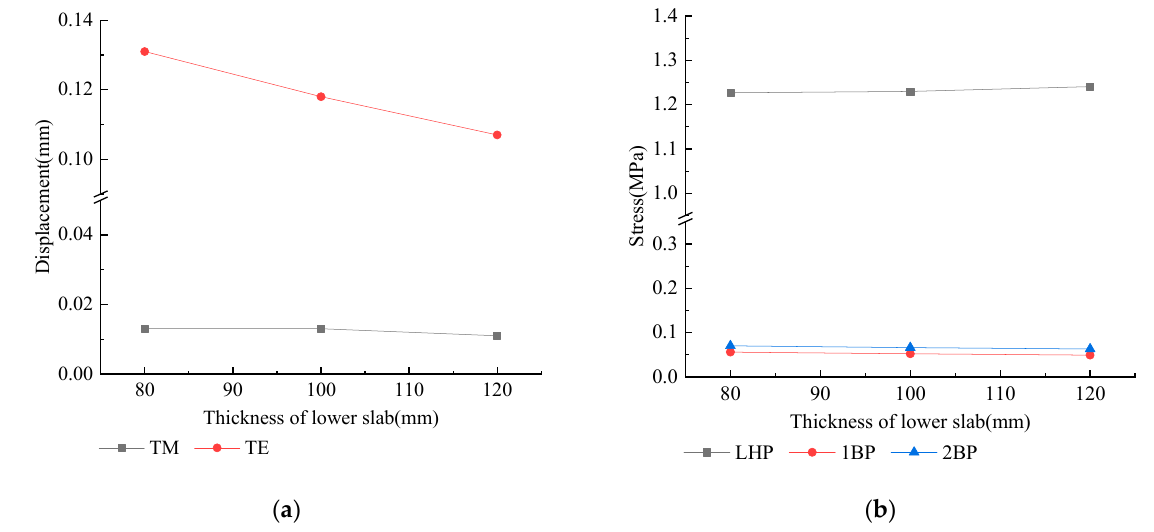
Figure 9. Trends of stress and displacement under different lower slab thickness conditions during the construction hoisting period. ( a ) Displacement and ( b ) stress.